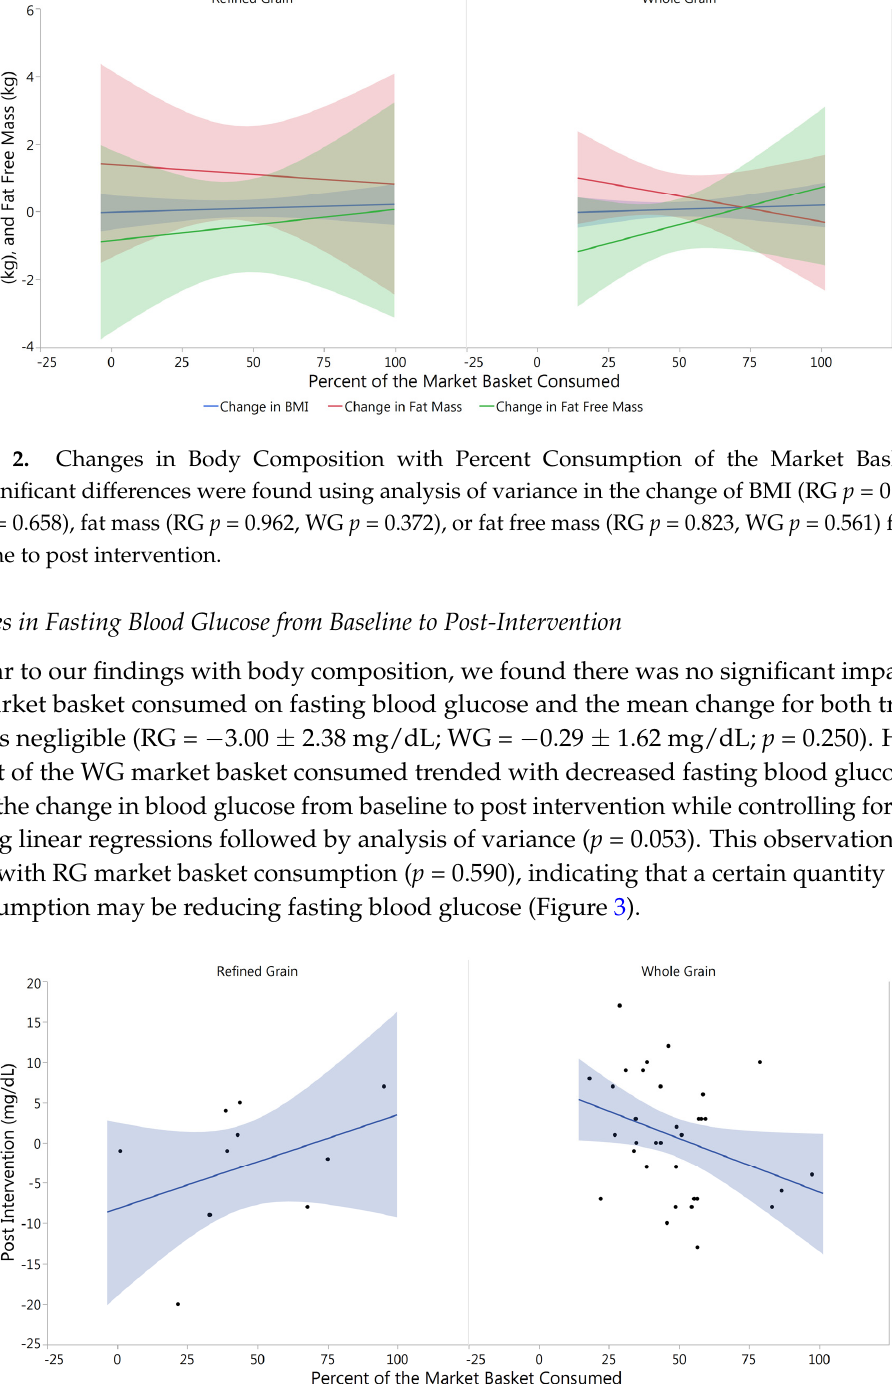
Figure 3. Percent of Market Basket Consumed Related to Change in Fasting Glucose. Increased consumption of the whole grain market basket was related to lower ( p = 0.053) fasting blood glucose in the whole grain treatment, whereas there was a pattern of increased blood glucose with increased consumption of the refined grain market basket ( p =